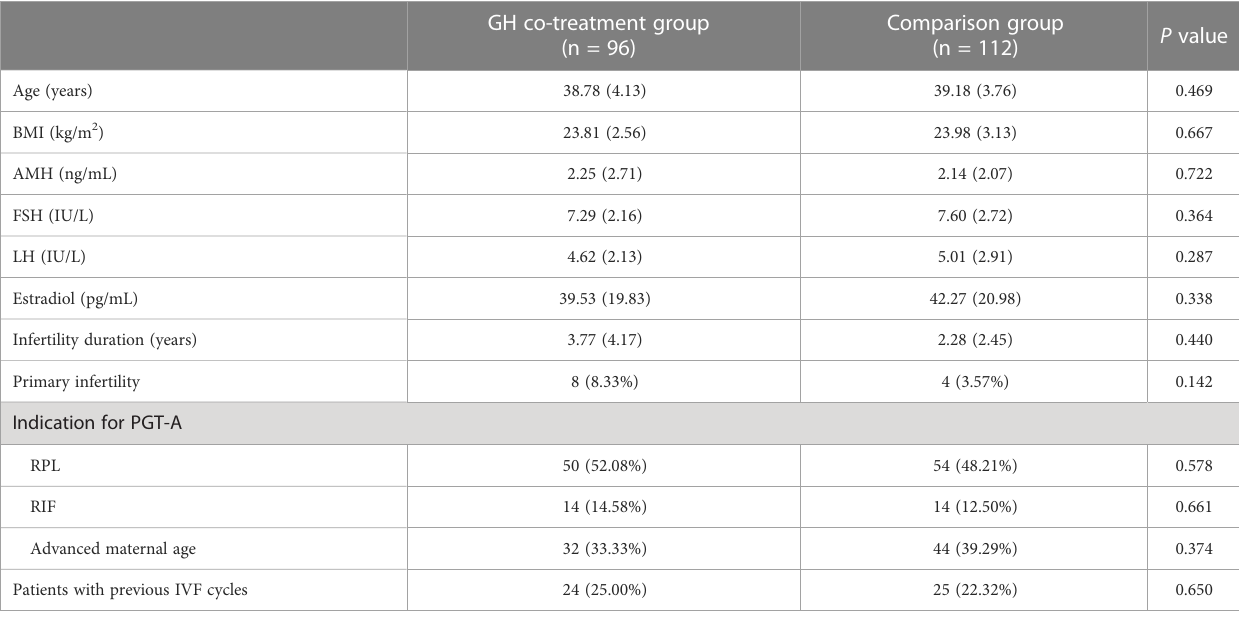
TABLE 1 Baseline demographic characteristics of